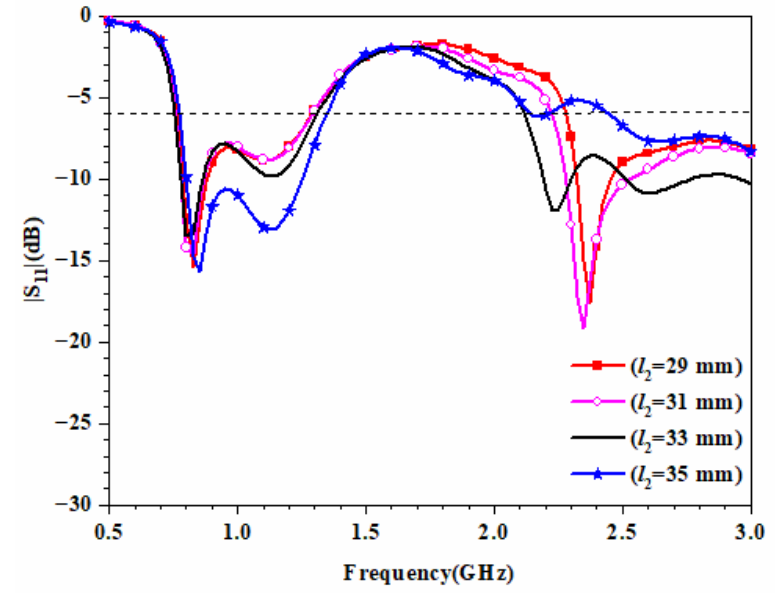
Figure 5. Influence of l 2 on |S 11 |.